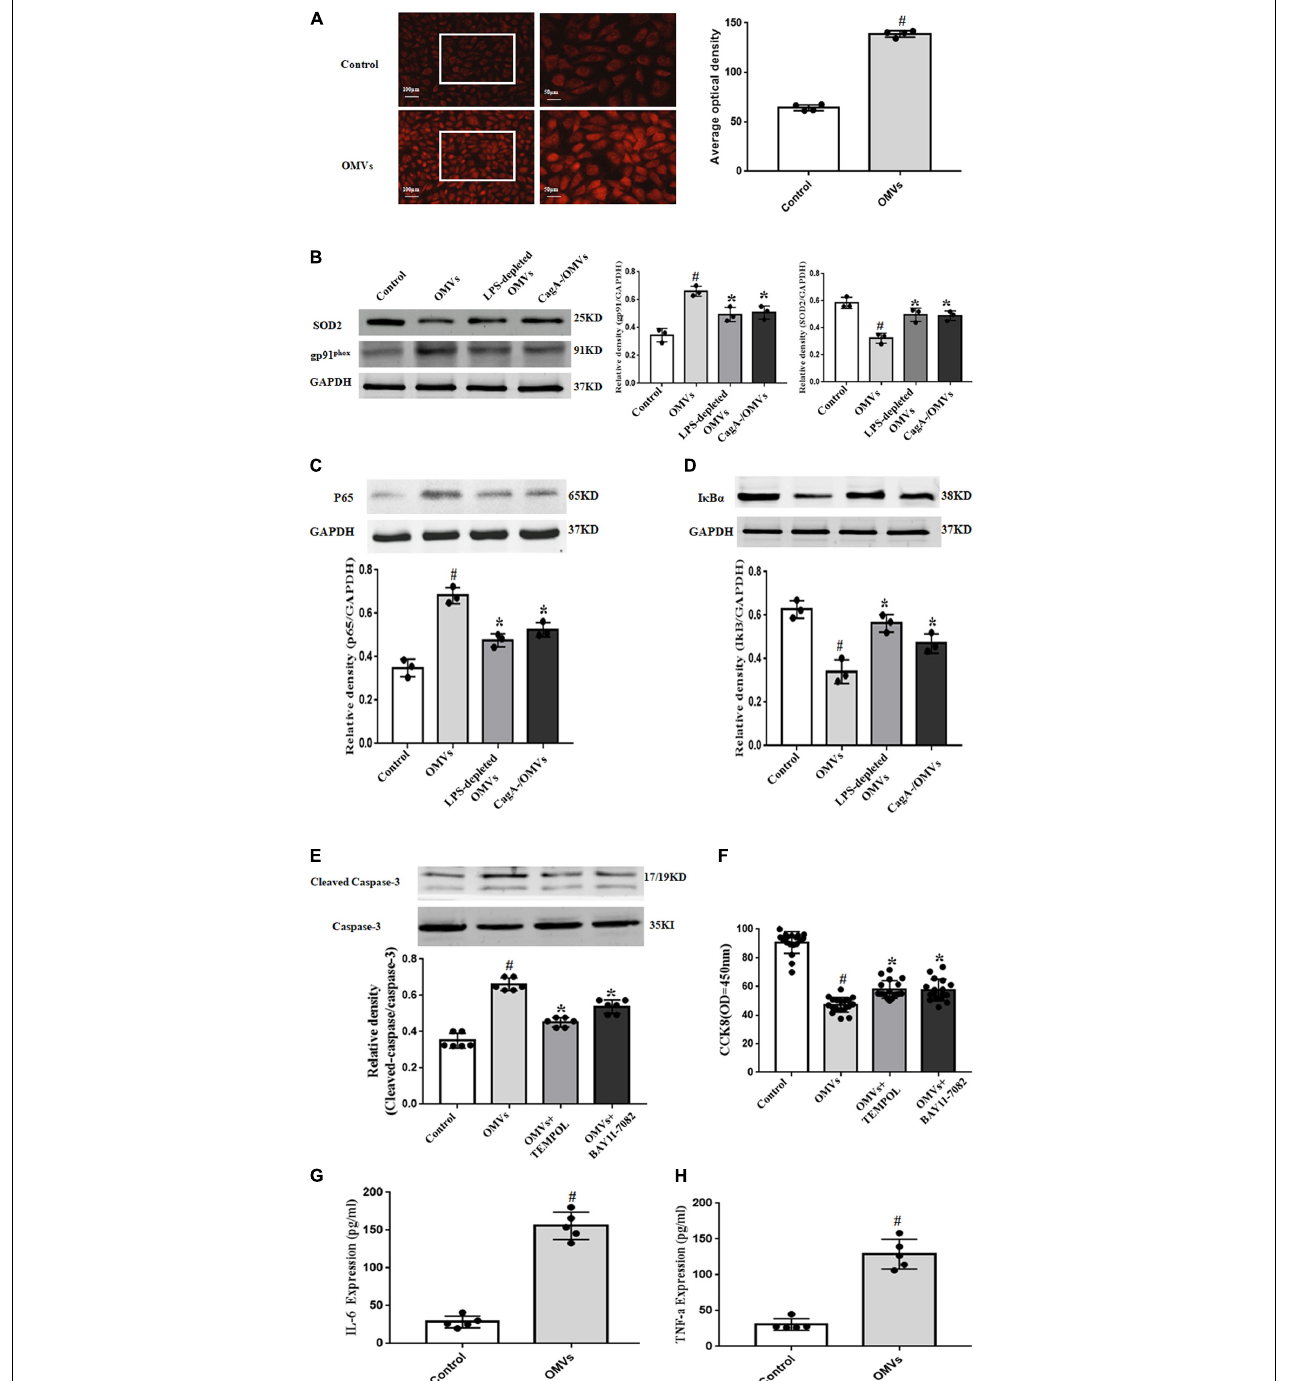
FIGURE 5 | Role of ROS/NF- κ B signaling pathway in H. pylori -derived OMVs-mediated effects in HUVECs. (A) ROS were determined by dihydroethidium staining in HUVECs treated with H. pylori -derived OMVs (10 µ g/mL) for 24 h ( n = 4, # P < 0.01 vs. control). (B–D) HUVECs were administrated with control (vehicle), OMVs (10 µ g/mL), LPS-depleted OMVs or CagA-negative OMVs for 24 h. The expressions of SOD2 and gp91 phox (B) , p65 (C) , I κ B α (D) were determined by immunoblotting ( n = 3, * P < 0.05 vs. OMVs or # P < 0.01 vs. control). (E) HUVECs were treated with control (vehicle), OMVs (10 µ g/mL), OMVs + TEMPOL, and OMVs + BAY11-7082 for 24 h. The expression of cleaved-caspase-3 and total caspase-3 were determined by immunoblotting ( n = 6, * P < 0.05 vs. OMVs or # P < 0.01 vs. control). (F) Proliferation of HUVECs were assayed by CCK8 after treatment with vehicle, OMVs (10 µ g/mL), OMVs + TEMPOL, and OMVs + BAY11-7082 for 24 h ( n = 17, * P < 0.05 vs. OMVs or # P < 0.01 vs. control). (G,H) ApoE − / − mice or control mice were intragastrically administered with vehicle or H. pylori -derived OMVs for 4 weeks. Levels of IL-6 (G) and TNF- α (H) were determined by ELISA ( n = 5, # P < 0.05 vs. control).